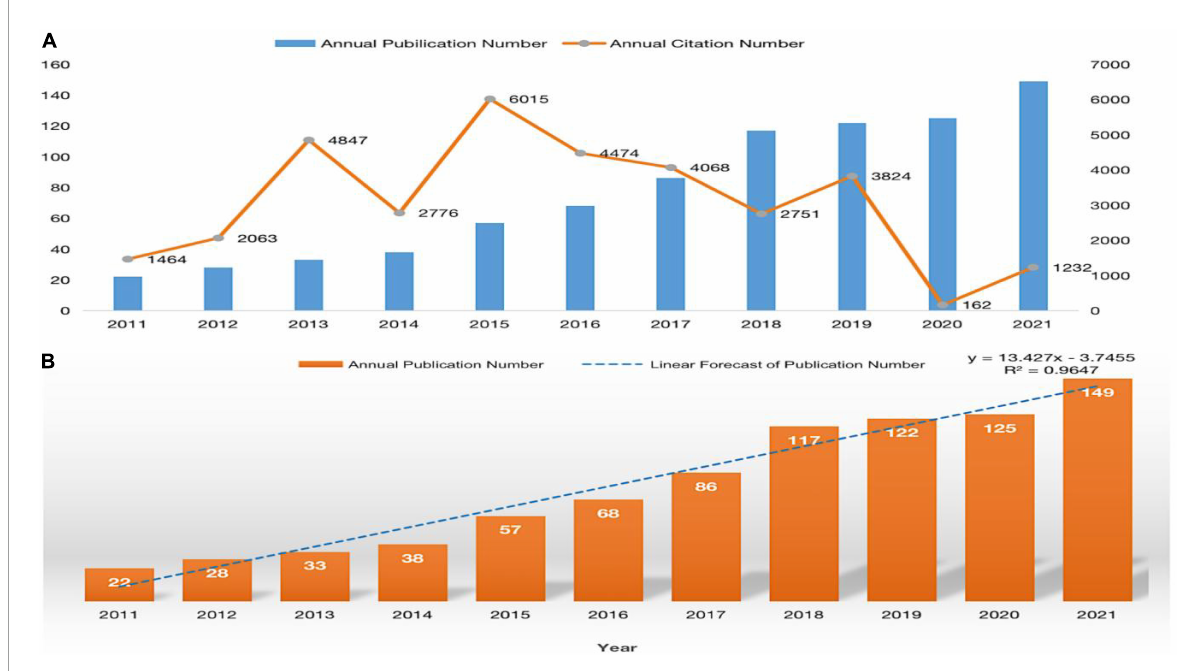
FIGURE2 (A) The distribution of annual publications and citations on neuroinflammation-induced MCI, (B) publication forecast